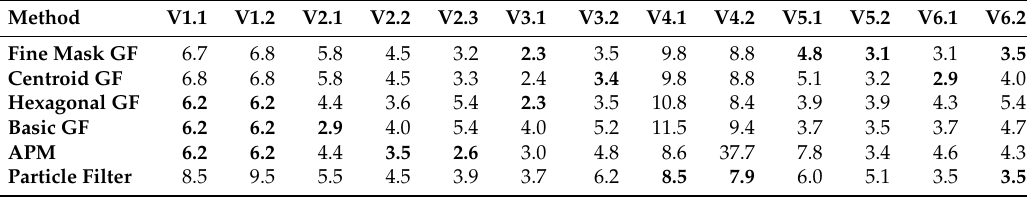
Table 3. Third quartiles of errors in meters for considered methods with the best overall result on each validation logfile.